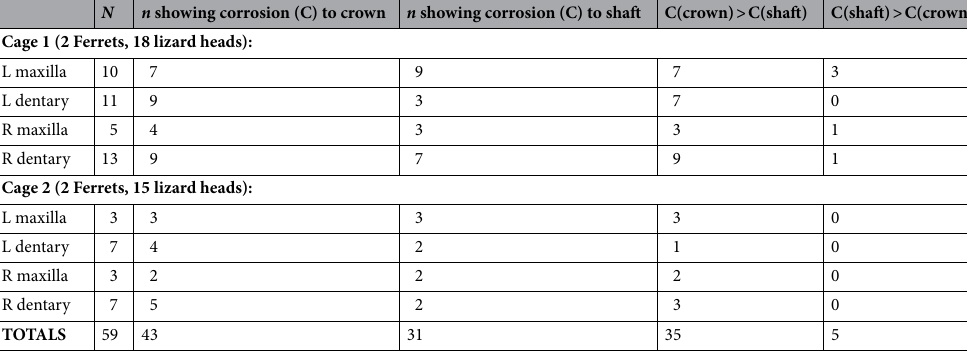
Table 1. Summary of corrosion damage to teeth of Green Anoles ( Anolis carolinensis ) ingested by Ferrets ( Mustela putorius ). A total of 48 jaws showed corrosion to crown or shaft, whereas 8 showed no corrosion. The remaining 3 jaws could not be cleaned sufficiently to